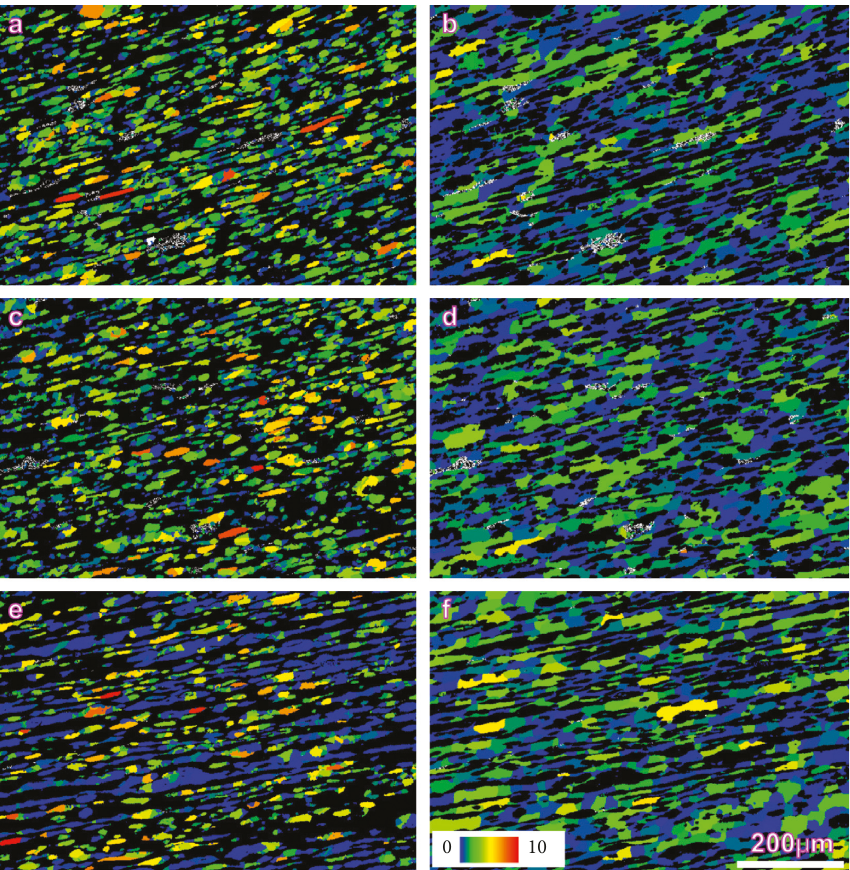
Figure 6: GOS maps of specimens strained at different strain rates to 0.4. (a, b) 0.005s –1 ; (c, d) 0.05s –1 ; (e, f) 0.5s –1 . (a), (c), and (e) are austenite phase, and (b), (d), and (f) are ferrite phase. The horizontal direction is the tensile axis.